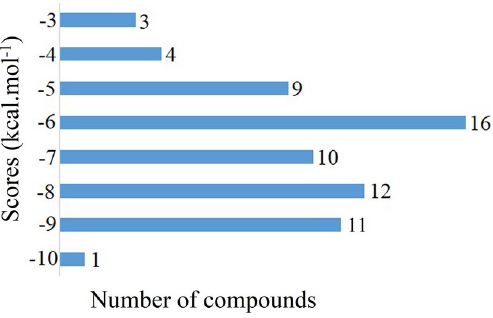
Figure 3. Showing the range of docking score distribution of sixty-six phytochemicals presence in the Rasam .